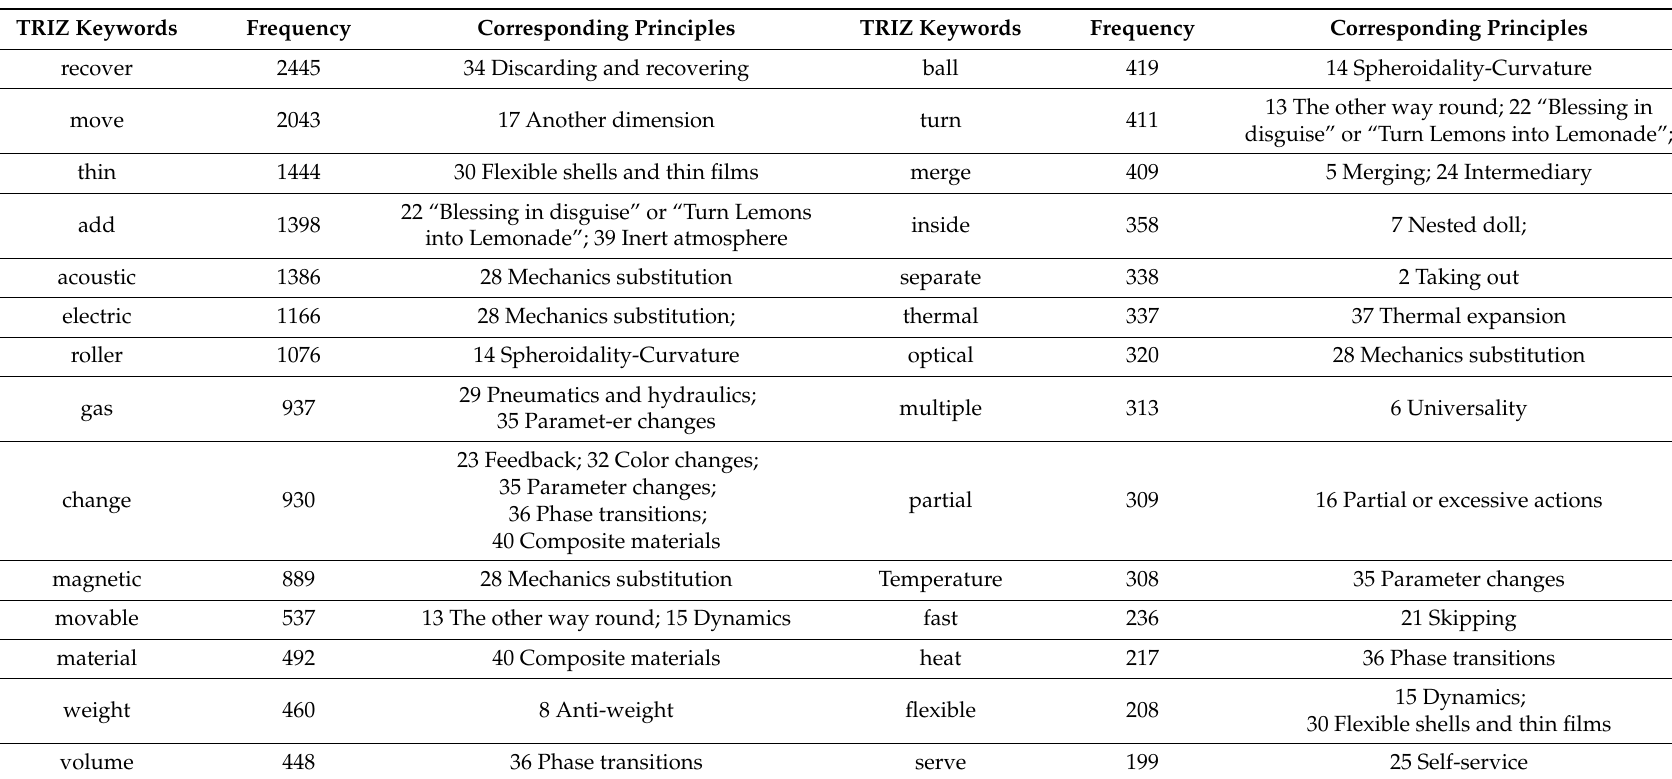
Table A4. Result of the occurrence frequency of extracted TRIZ